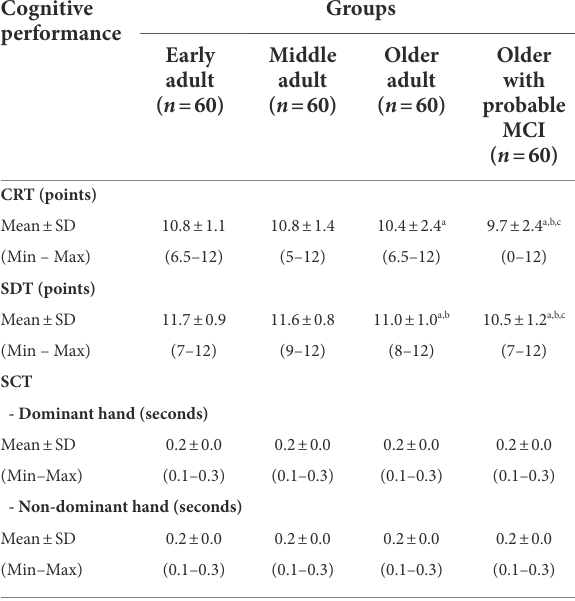
TABLE 2 The effect of age and MCI on the domains of perceptual- motor function. Cognitive performance